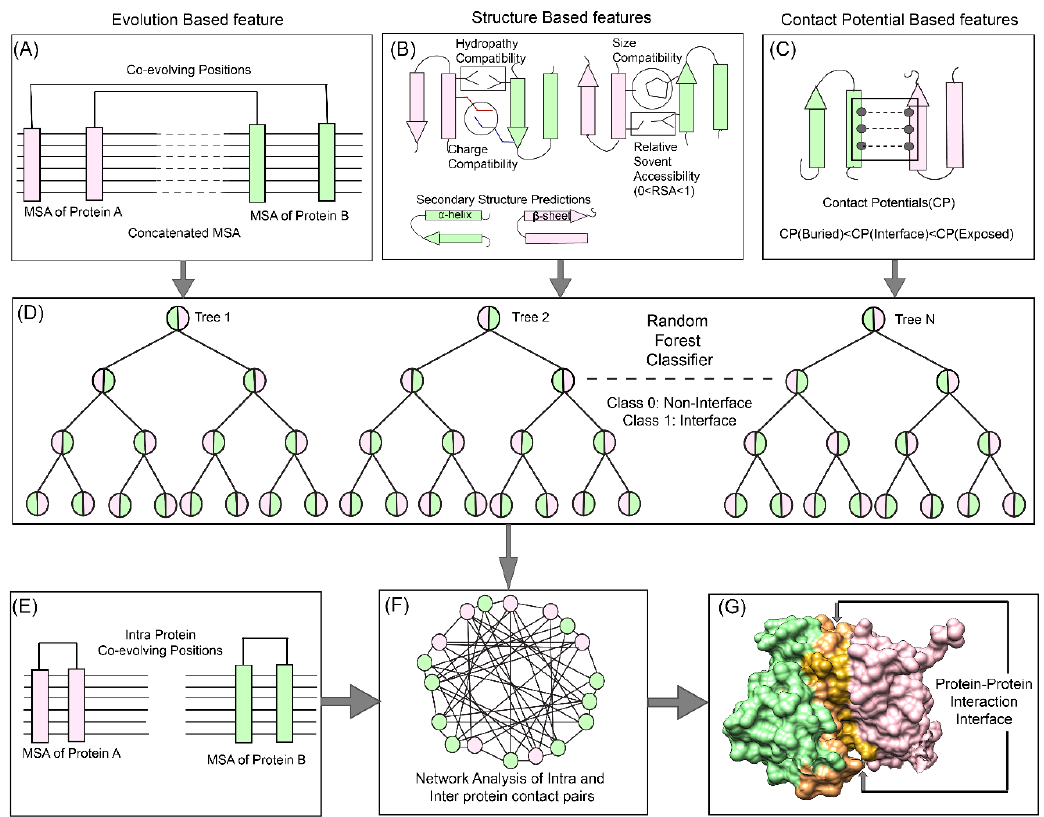
Figure 1. Co-evolution, Random Forest (machine learning (ML) method), and Network Analysis (CoRNeA) pipeline for predicting co-evolving contact forming residues in an interacting pair of proteins. The method for predicting the protein-protein interaction interface consists of three levels. The top panel depicts the features used for machine learning pipeline. ( A ). Evolutionary information-based (Co-evolution) ( B ) Structure-based (Charge, Size, Hydropathy, Secondary structure, and Relative solvent accessibility) and ( C ) contact potential- based features (both for buried and exposed residues). ( D ) Random Forest classification where pairwise values for both proteins are considered depicted in half green and pink circles for binary classification (Class 1: protein interface, Class 0: non-interface). The bottom panel depicts the application of network analysis by combining intra and inter-protein contact predictions for reducing the false positives. ( E ) Prediction of intra-contacts of Protein A and B. ( F ) Combined network analysis of inter and intra predicted contacts. ( G ) Interface prediction for core binding protein alpha subunit with core binding protein beta subunit (protein structure database (PDB) ID: 1H9D).